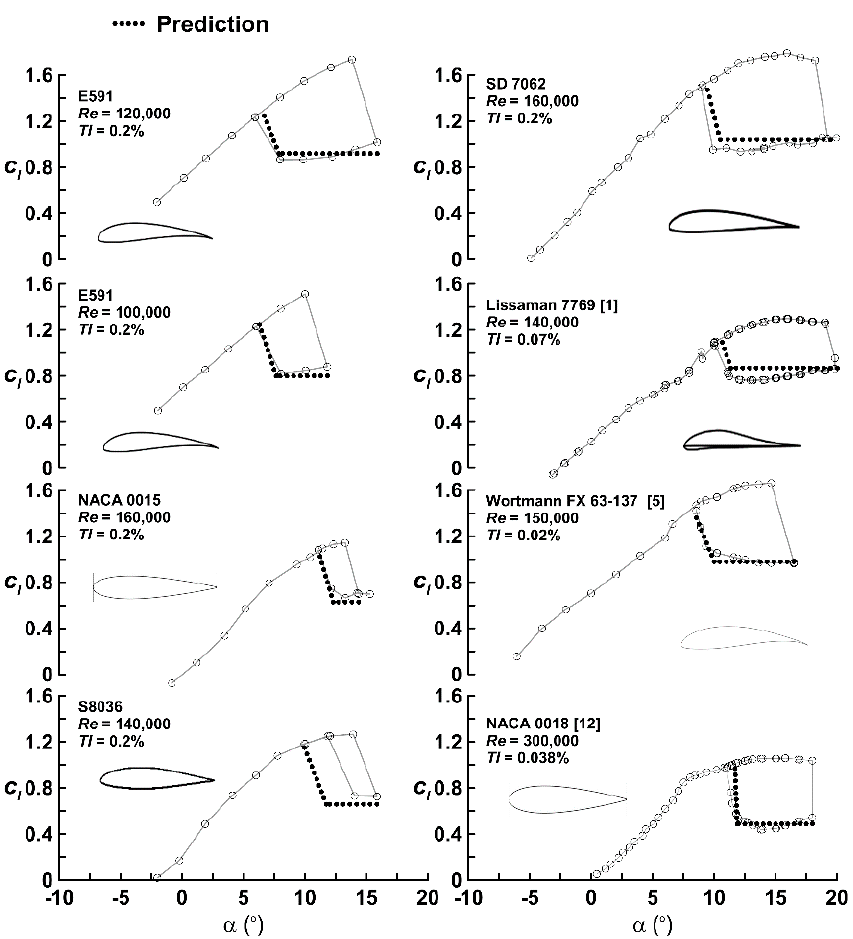
Figure 3. Comparison of experiment and prediction for various airfoils.